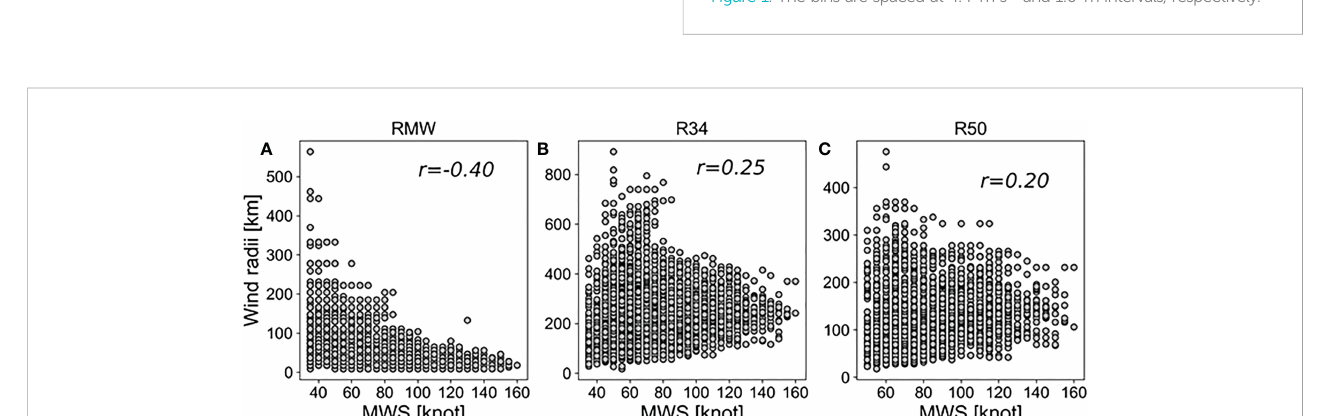
FIGURE 9 Comparison of the number of samples against each bin at various (A) wind speeds (over 10 m s -1 ) and (B) signi fi cant wave heights (over 5 m) within the TC (up to 900 km from the storm center) between the two cases in Figure 1. The bins are spaced at 4.4-m s -1 and 1.6-m intervals, respectively.